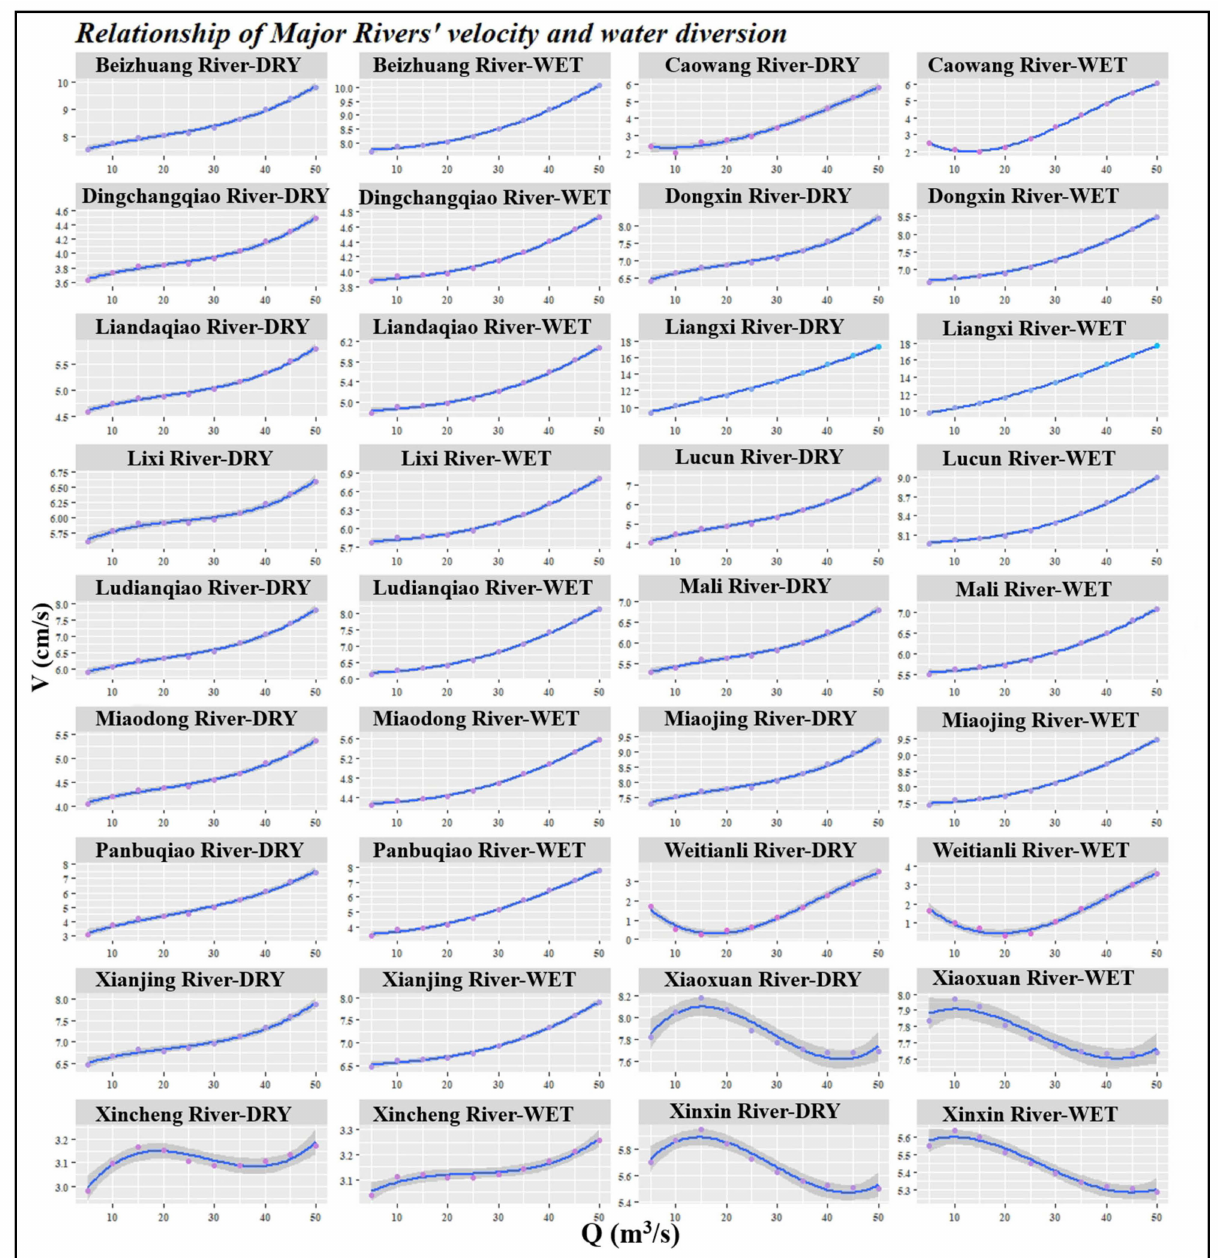
Figure 6. Cubic polynomial fitting curves of Meiliang Lake pumping station water diversion flux and rivers flow velocity are displayed. Note: The grey shadow represents 95% confidence